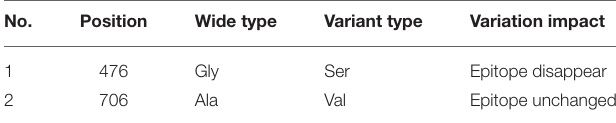
TABLE 2 | Variations in discontinuous B cell epitope prediction of SARS-CoV-2 spike protein and its impacts.